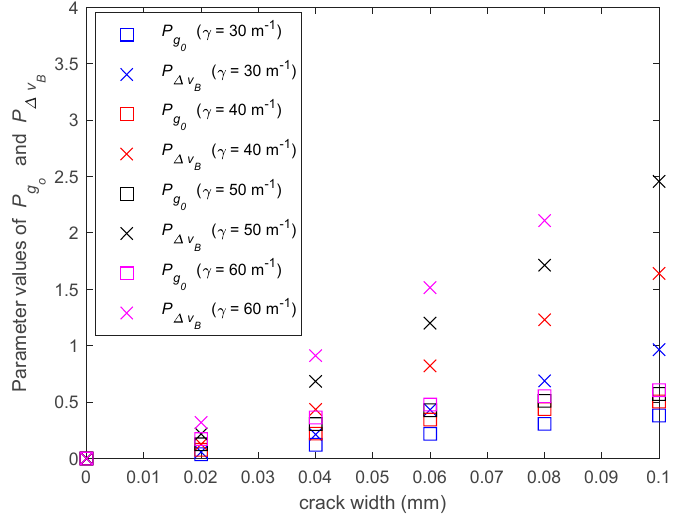
ff erent shear lag